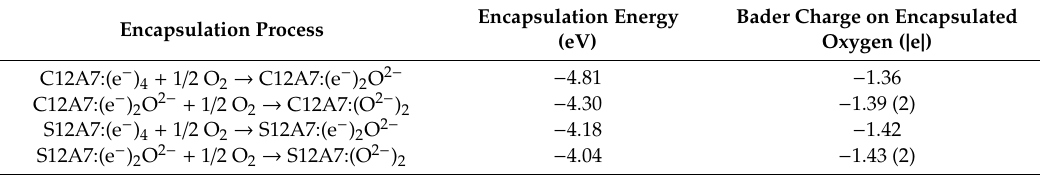
Table 3. The encapsulation energies and Bader charge on the encapsulated oxygen atoms. Encapsulation